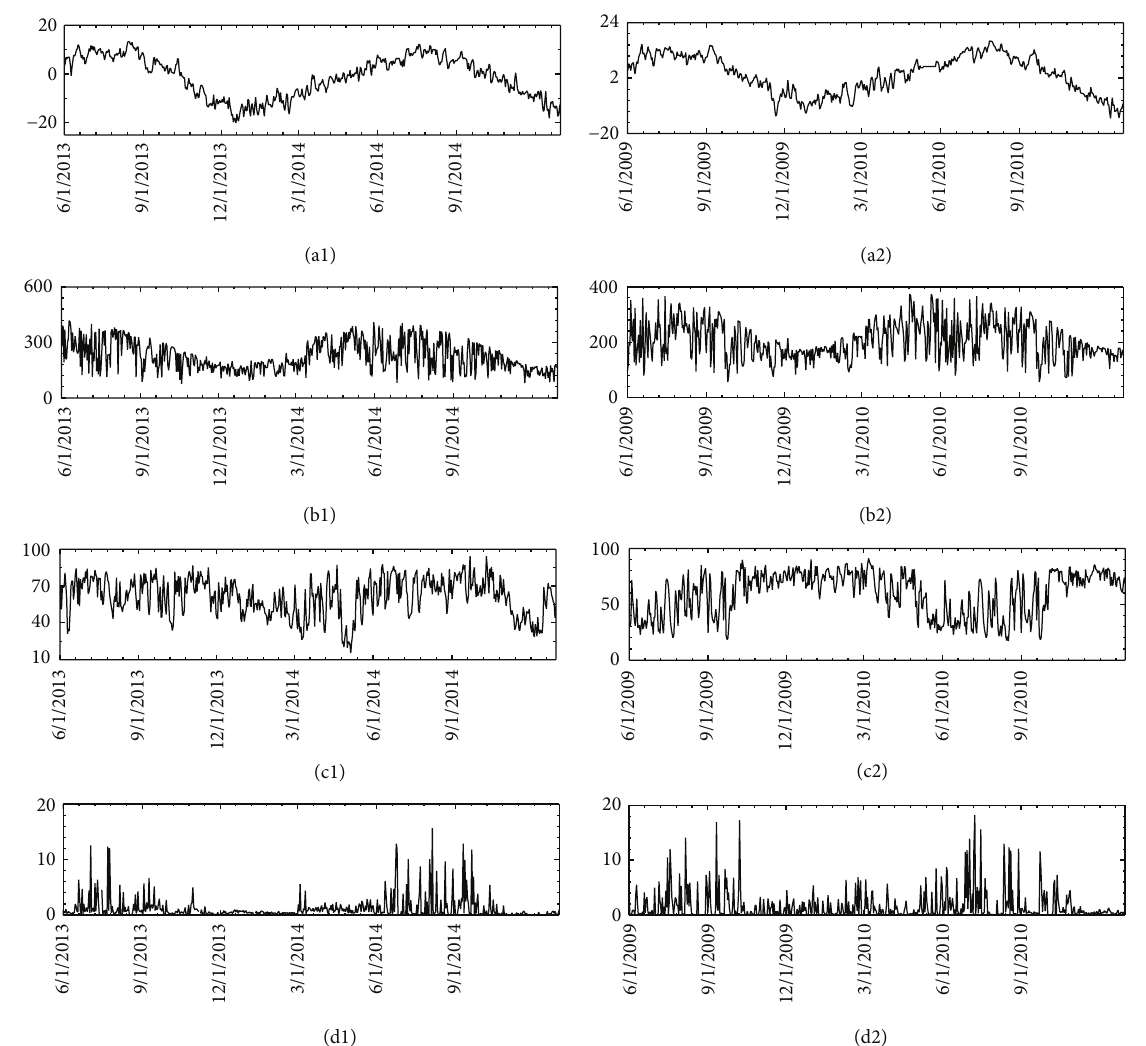
Figure 2: The main forcing data at Madoi (left panel, from 6/1/2013 to 12/31/2014) and Zoige site (right panel, from 6/1/2009 to 12/31/2014) on the Tibetan Plateau (TP). (a1), (a2) Temperature ( ∘ C); (b1), (b2) incident solar (Wm −2 ); (c1), (c2) specific humidity (%); (d1), (d2) precipitation (mmday −1